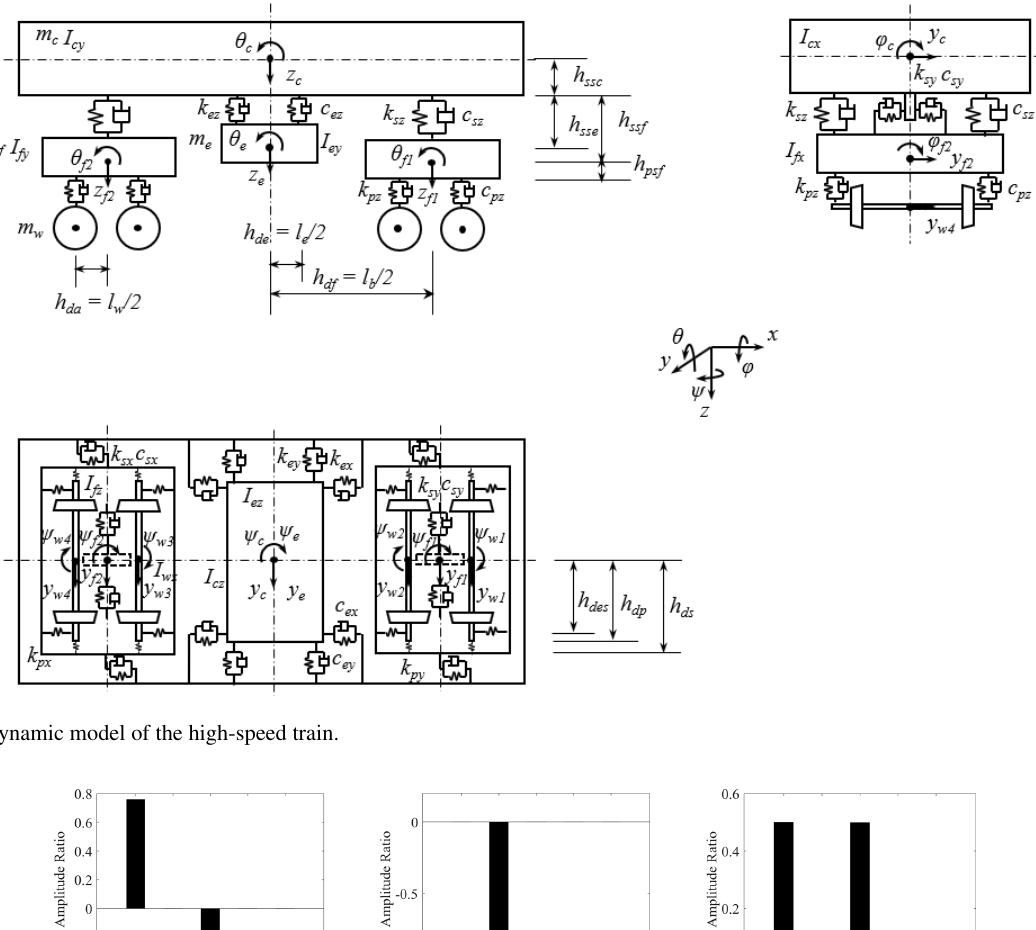
Figure 4. Dynamic model of the high-speed train.